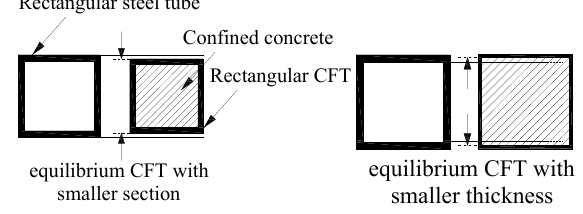
Figure 12. CFST columns equivalent to the HSS (hollow steel section) columns. Table 1. Details of various high ‐ rise building models.